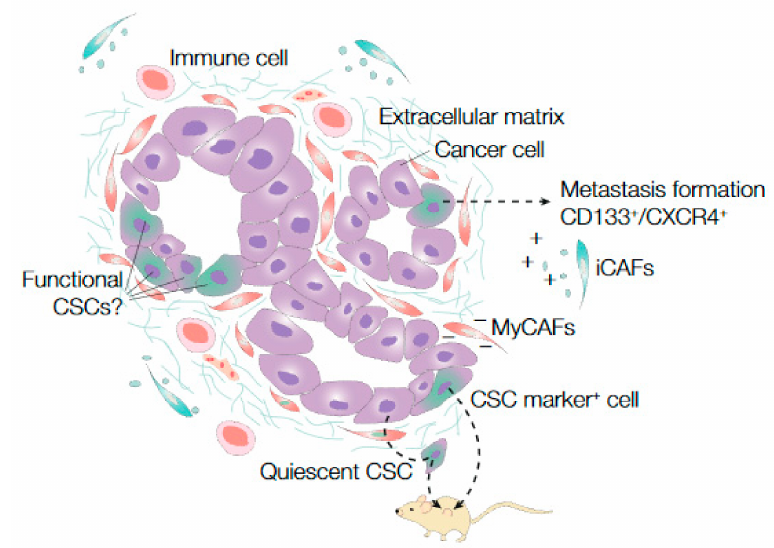
Figure 3. Cancer stem cell dynamics in PDAC. Pancreatic ductal adenocarcinoma (PDAC) is charac- terized by thick stromal fibers (extracellular matrix) that compress blood vessels and cause hypoxia. In PDAC, different putative cancer stem cell (CSC) markers have been identified in cancer cell populations that showed self-renewal, multipotency, or metastasis formation (CD133 + /CXCR4 + cells) capacity after transplantation in immune compromised mice. Serial lineage tracing experiments showed that quiescent CSCs become activated after transplantation in mice. Little is known about the cancer cells that drive tumor progression (the functional CSCs) within established PDAC tissue. Different microenvironmental factors, including subpopulations of fibroblasts that secrete tumor growth promoting factors (iCAFs) and immune cells, are suggested to influence CSC functional- ity in PDAC. Meanwhile, other CAF subpopulations, such as myCAFs, are proposed to be tumor growth